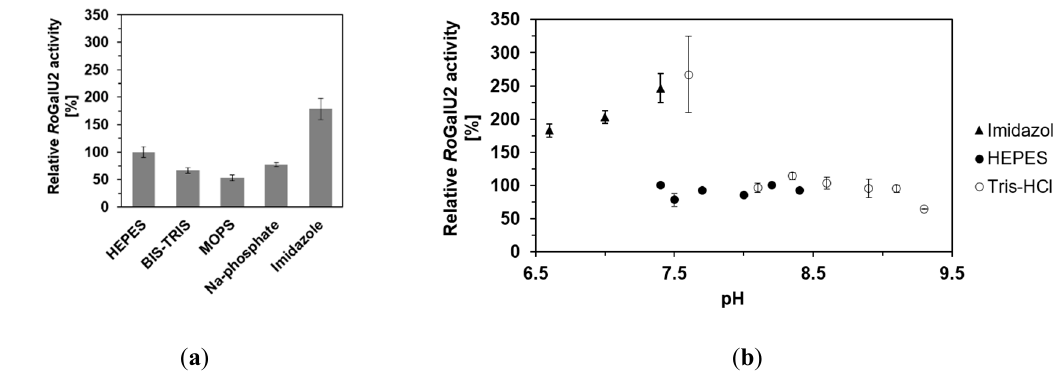
Figure 8. Ro GalU2 enzyme activity depending on the buffer ( a ) and pH ( b ) of the reaction solution. ( a ) Assay mixtures contained 1.5 mM UTP, 250 mM glucose 1-phosphate, 1 mM MgCl 2 , 50 mM buffer, pH 7.4, 1.7 µg Ro GalU2. Reaction was carried out at 42 °C in 1 mL volume. ( b ) Assay mixtures contained 1.5 mM UTP, 250 mM glucose 1-phosphate, 1 mM MgCl 2 , 50 mM Imidazole, pH 6.6–7.4 (black triangle) or 50 mM Hepes, pH 7.4–8.4 (black circle) or 50 mM Tris-HCl, pH 7.6–9.3 (white circle), 1.7 µg Ro GalU2. Reaction was carried out at 42 °C in 1 mL volume. Means with standard deviations are shown out of a minimum set of three independent measurements. 100% relative activities correspond to 126 U mg − 1 ( a ) and 109 U mg − 1 ( b ).